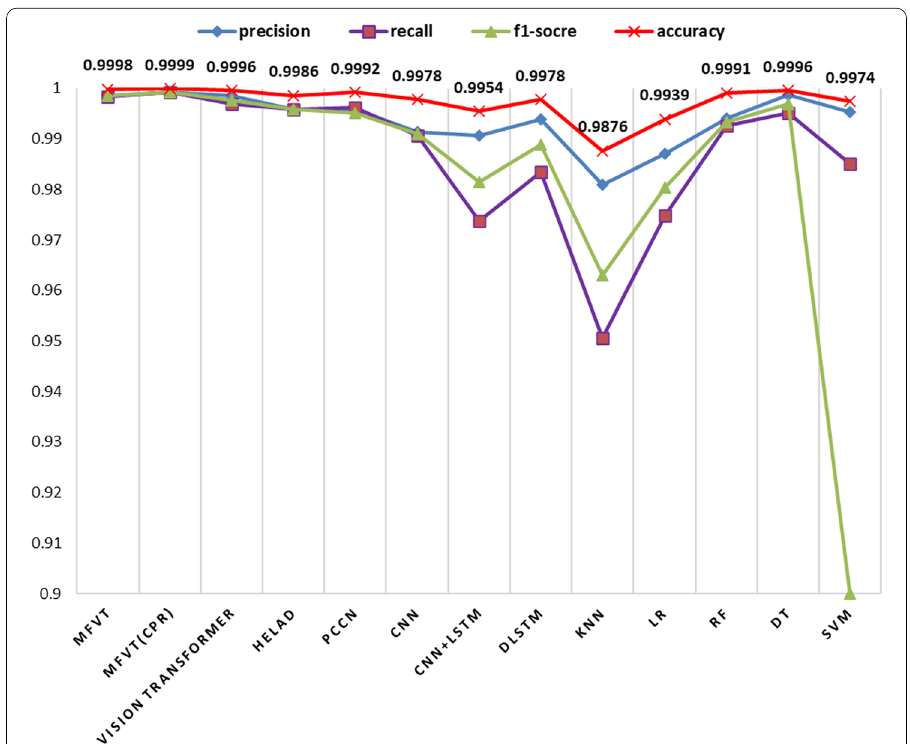
Fig. 7 Partial experimental results, blue represents precision, purple represents recall, green represents F1‑score, and red represents